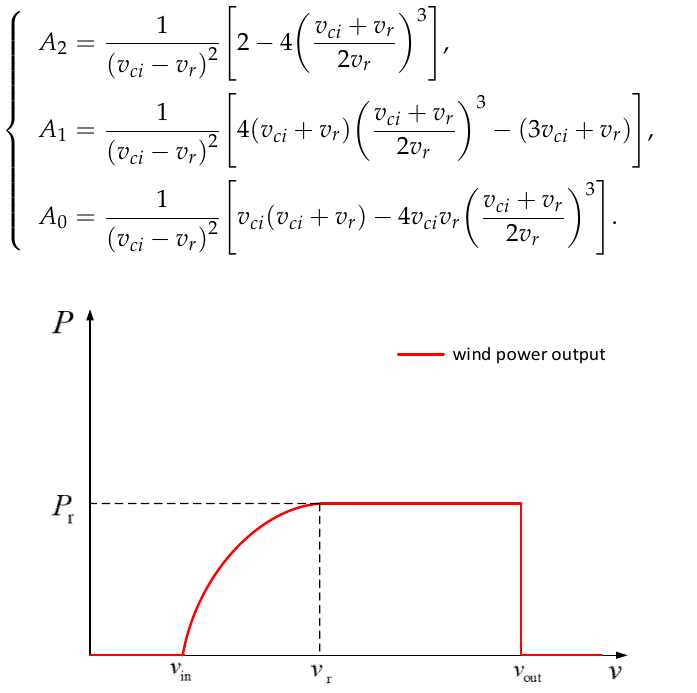
Figure 1. Relationship between wind power output and wind speeds according to Equation (1).